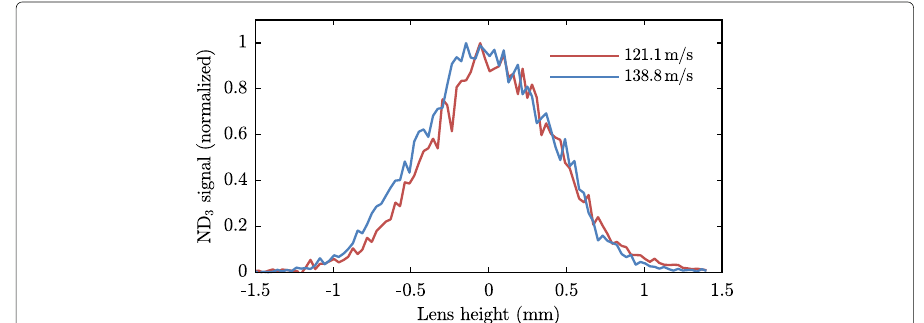
Fig. 5 Laser height scans of ammonia packets traveling at 121.1 and 138.8 m/s at detection zone